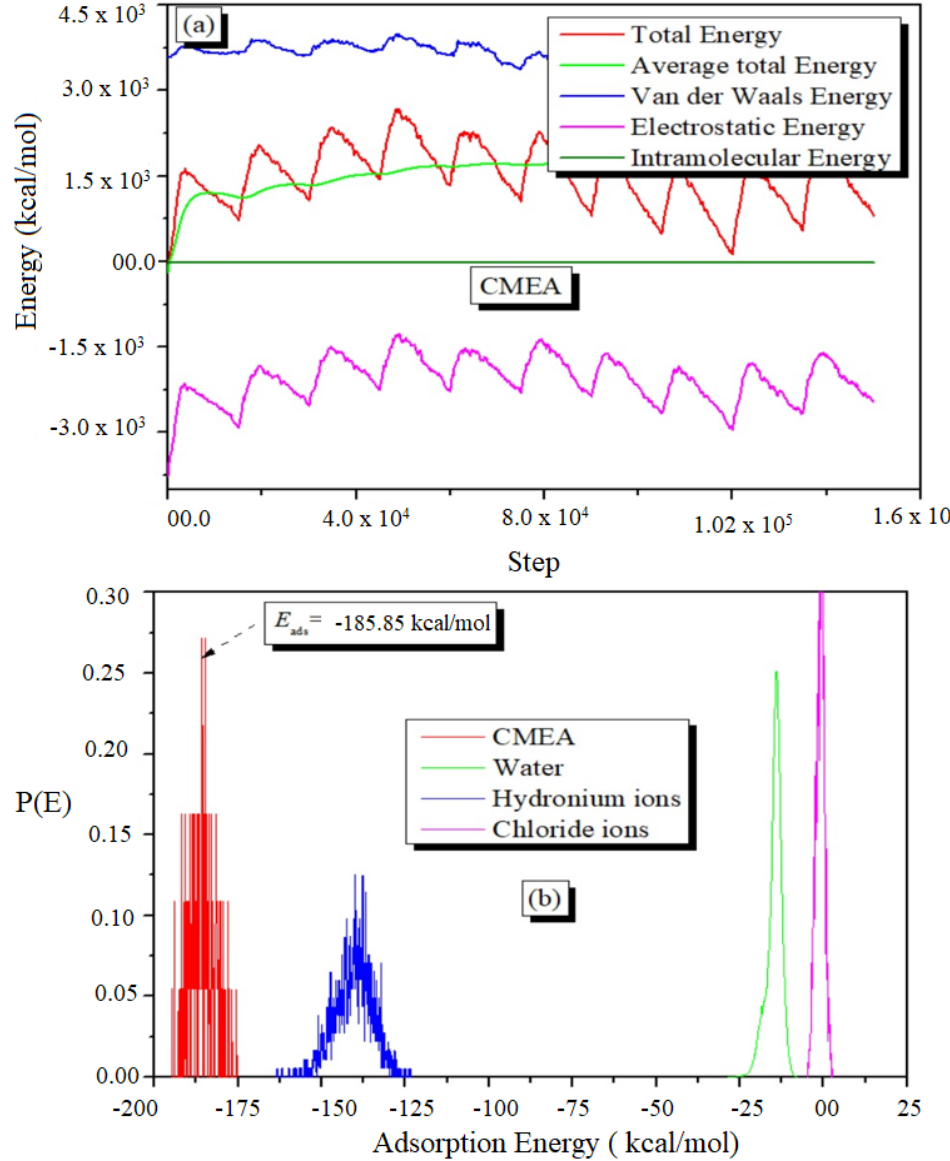
Figure 14. The engrossment of the various energy components throughout the MC calculations ( a ) and distribution of the CMEA inhibitor’s adsorption energies on the surface of iron ( b ).